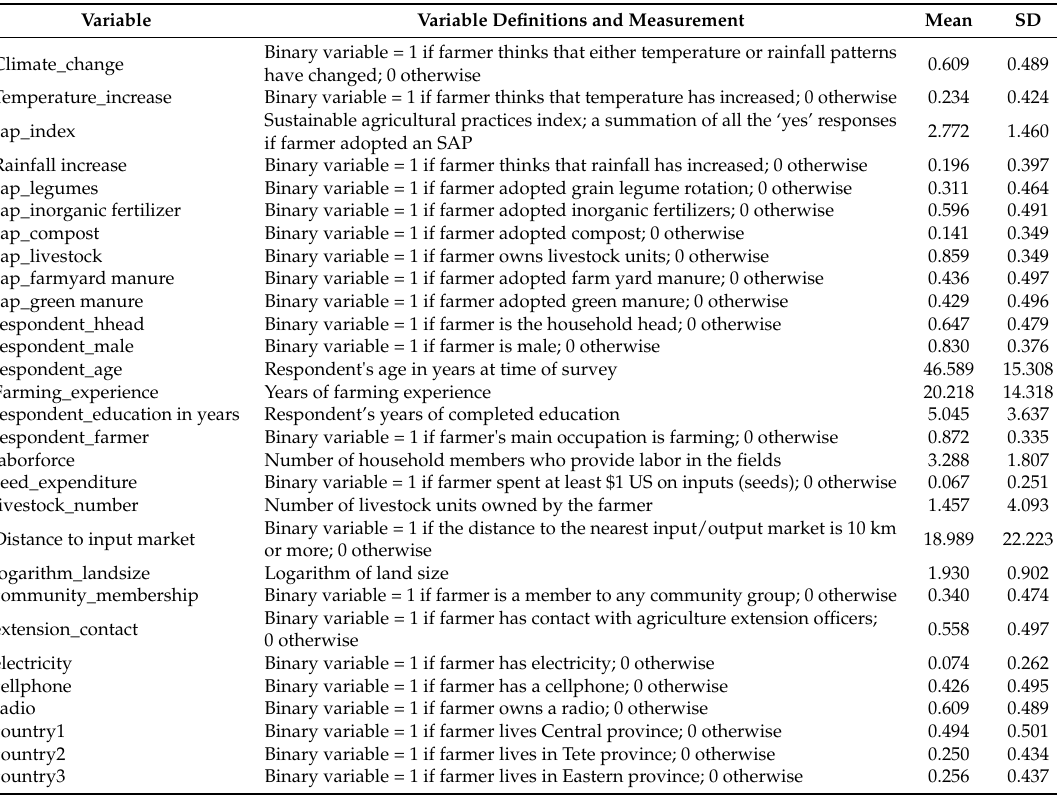
Table 1. Descriptive statistics and variable definitions ( n =